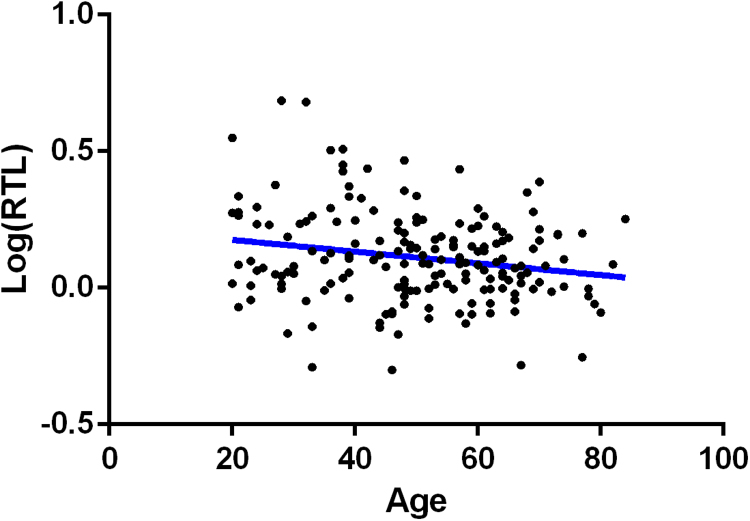
A scatterplot showing a negative correlation between chronological age, x-axis, and log(RTL), y-axis. Line represents the line of best fit.